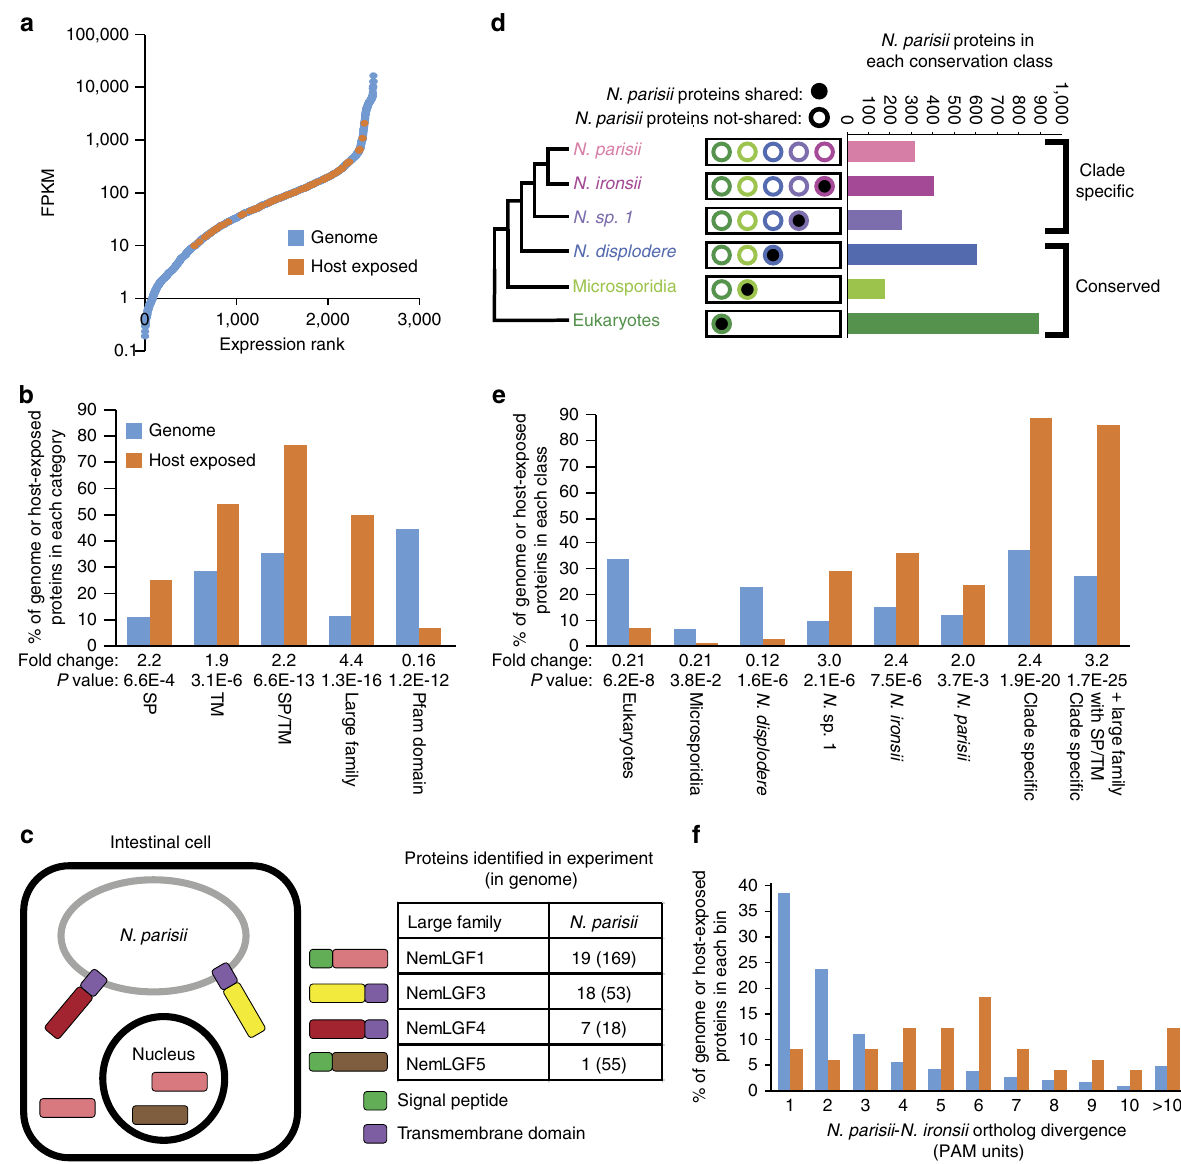
Figure 2 | Properties of experimentally identified N. parisii host-exposed proteins. ( a ) Comparison of mRNA expression levels of identified host-exposed proteins (orange dots) to the rest of the expressed N. parisii proteins (blue dots). Expression data are from a previous RNAseq study on animals infected for 30h at 25 (cid:2) C (ref. 58). ( b , e ). Comparison of identified host-exposed proteins (orange) to the genome (blue). Enrichment-fold change and P -values (one- side Fisher’s exact test) of the host-exposed proteins compared with the genome are listed below each category. ( b ) Properties of 72 N. parisii host- exposed proteins. The percentage of the N. parisii genome and the percentage of the host-exposed proteins in each category are shown. TM, transmembrane. SP, signal peptide. ( c ) Left, model of where identified large gene family proteins are localized. Right, the number of proteins of each gene family identified as host exposed and the total number of gene family members present in the genome is shown in parentheses. ( d ) Schematic of the categorization of N. parisii proteins by conservation class. The 2,661 proteins in the genome were placed into six classes of decreasing conservation from proteins conserved with eukaryotes to being proteins unique to N. parisii . ( e ) Percentage of the genome and host-exposed proteins in each conservation class. ( f ) Distribution of protein sequence divergence between N. parisii and N. ironsii one-to-one orthologs. The genome contains 2,083 orthologs that met our criteria and the host-exposed proteins contain 49 orthologs (See ‘Methods’ section). The percentage of the identified host-exposed proteins (orange) and the genome (blue) is plotted. Wilcoxon two-sample test comparing sequence divergence of orthologs in the genome to the host-exposed proteins has P -value of 6.8E (cid:2)